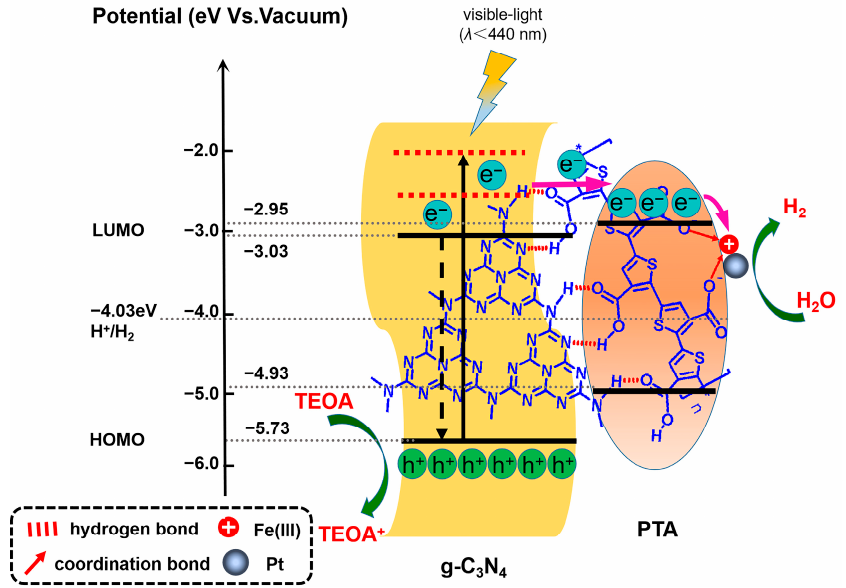
Figure 8. Mechanism of photogenerated charge separation and corresponding photochemical reac- tions in Fe(III)-coordinated PTA/g-C 3 N 4 nanoheterojunctions.